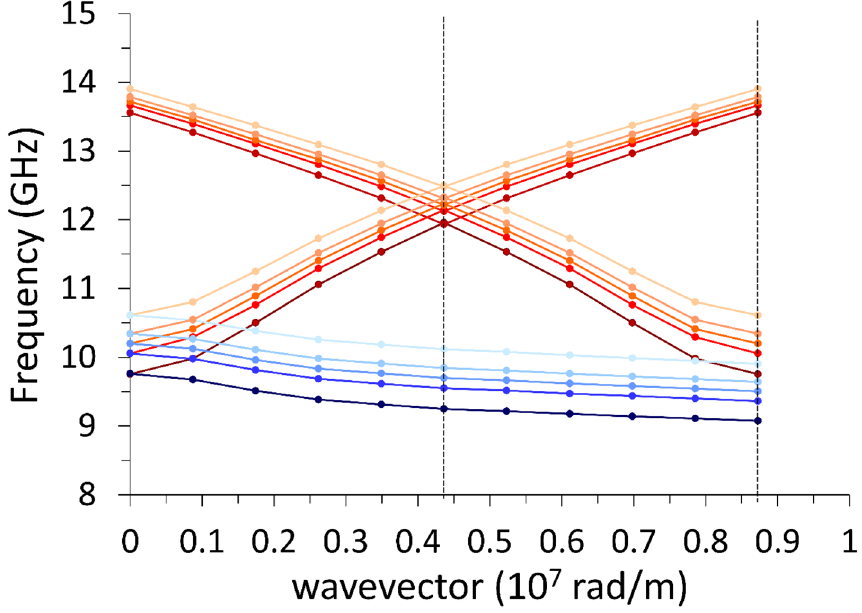
Figure 5. Dispersion curves in the 1st and mirrored 2nd Brillouin zone of the DE mode (red shades) and of the BA mode (blue shades), when M (cid:31) y . Lines are guides for the eyes. The vertical dashes mark the first and second zone boundaries (relevant to DE mode only). The variation of the undulation amplitude A is represented by the variation of shade: the darkest is the planar film ( A = 0 ), the lighter is the 12-stripe system ( A = 60 nm). Frequency increases about 0.14 GHz every (cid:31) A = 10 nm. The curves corresponding to the 2nd zone are less accurate, because of the finite discretization of the sample. Despite propagating along the direction where magnetization is uniform (y), the BA mode is nonetheless sensitive to the undulation amplitude